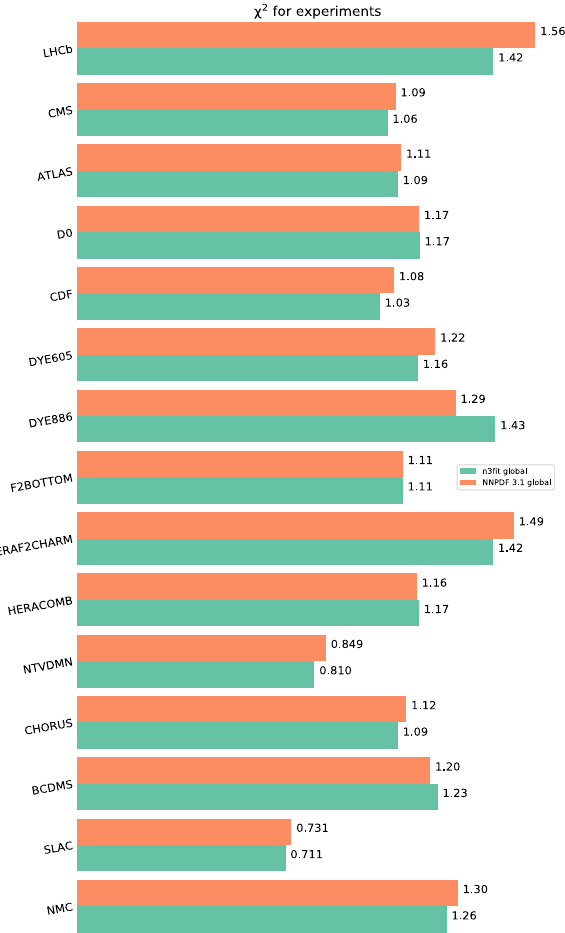
lengths of Fig. 7 with those produced by the global